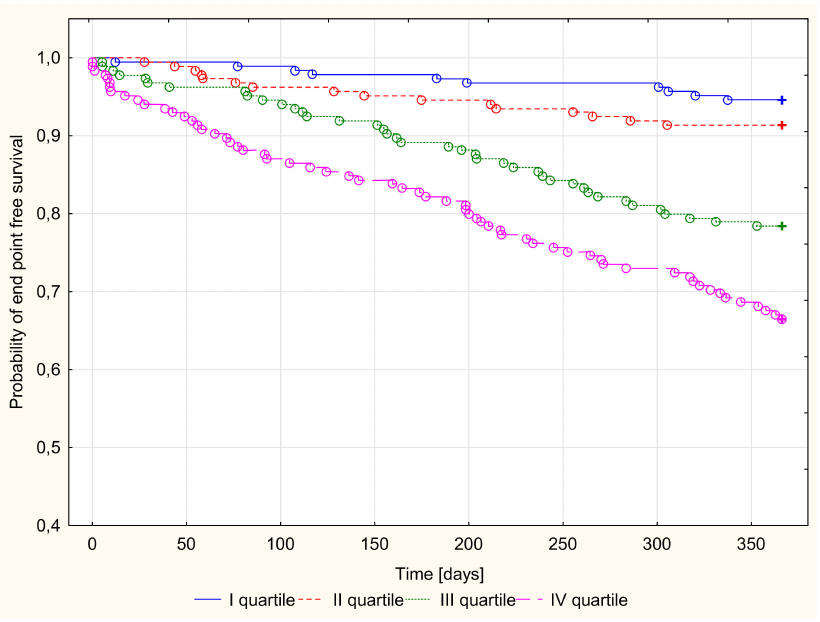
Figure 2. Probability of survival of time free of death or heart transplantation depending on quartiles of NT-proBNP concentrations in 1-year follow-up, p <